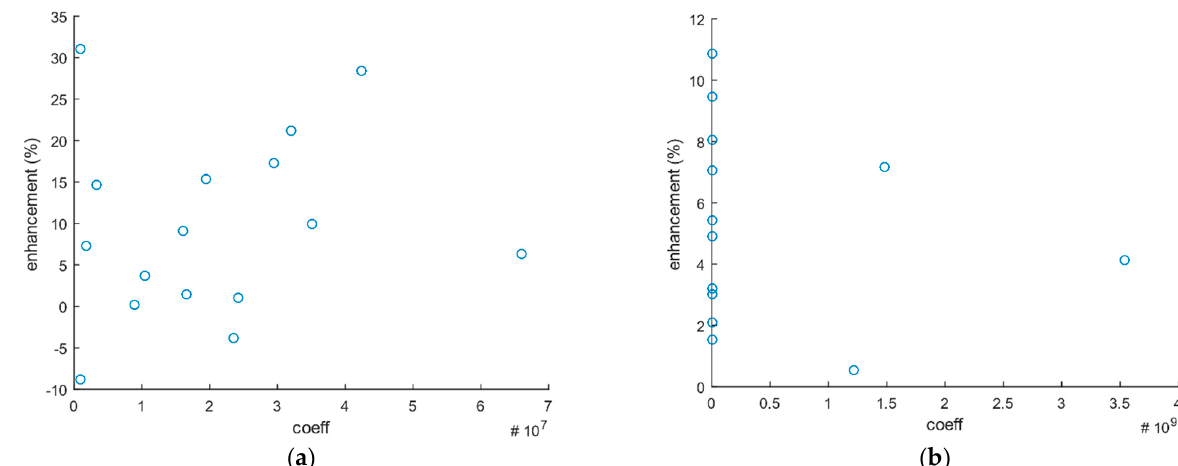
Figure 3. Enhancement vs. µ c graphs upon best resulting algorithms reported in Table 2: ( a ) Indian P.; ( b ) KSC (enhancement, class-based classification accuracy difference in percent between the proposed method + existing manifold learning algorithm and existing manifold learning algorithm; coeff, µ c , class-based coefficients proposed with this study). (Note that every circle represents a class. The figure reports class-based accuracy enhancements and µ c coefficients calculated for every class. The coefficient µ c is related to the scattering level of intra-class samples and specific for every class. Class-based success of the proposed method can be evaluated.for every dataset and compared with the coefficients proposed).